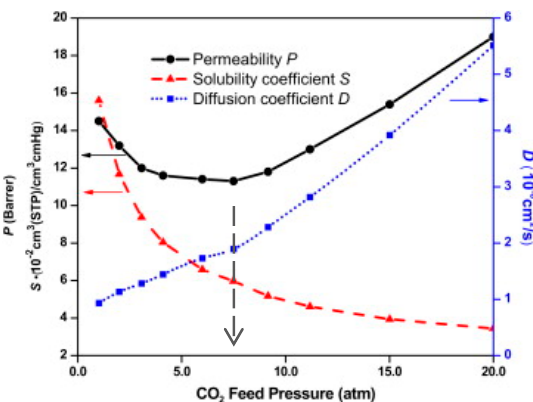
Figure 7. Experimental measurement of CO 2 permeability, solubility and diffusion coefficient as a function of pressure in a polyimide membrane. The black dashed-line arrow is indicative of the characteristic pressure (“plasticization pressure”) that corresponds to the minimum of permeability. Reproduced with permission from [183] .